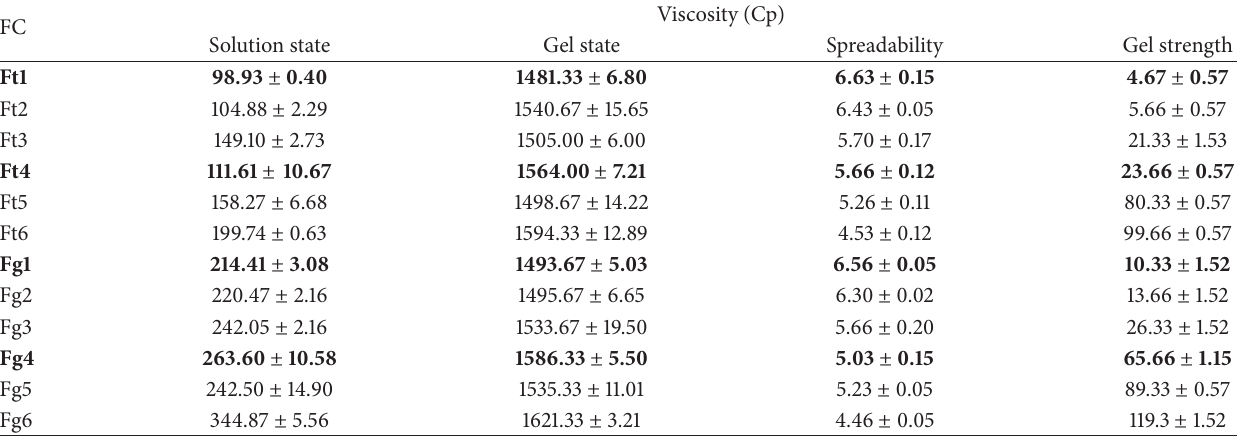
Table 5: Evaluation data 2 of in situ gel